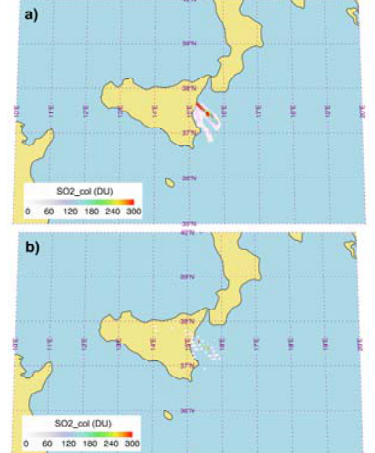
Figure 1: MODIS 10 April 12.27 GMT SO 2 column amount: a) INGV and b) RAL.